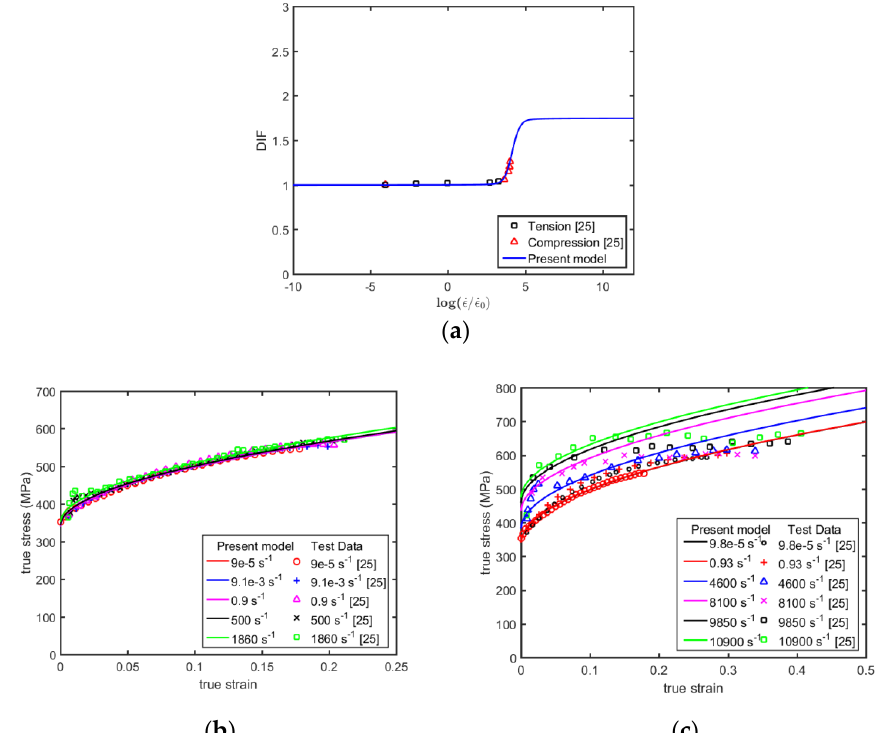
Figure 2. Comparison of the present model with the test data for 2024-T351 aluminum alloy at room temperature. ( a ) DIF versus strain rate at a plastic strain of 0.075; ( b ) true stress–true strain curves in tension and ( c ) true stress-true strain curves in compression.